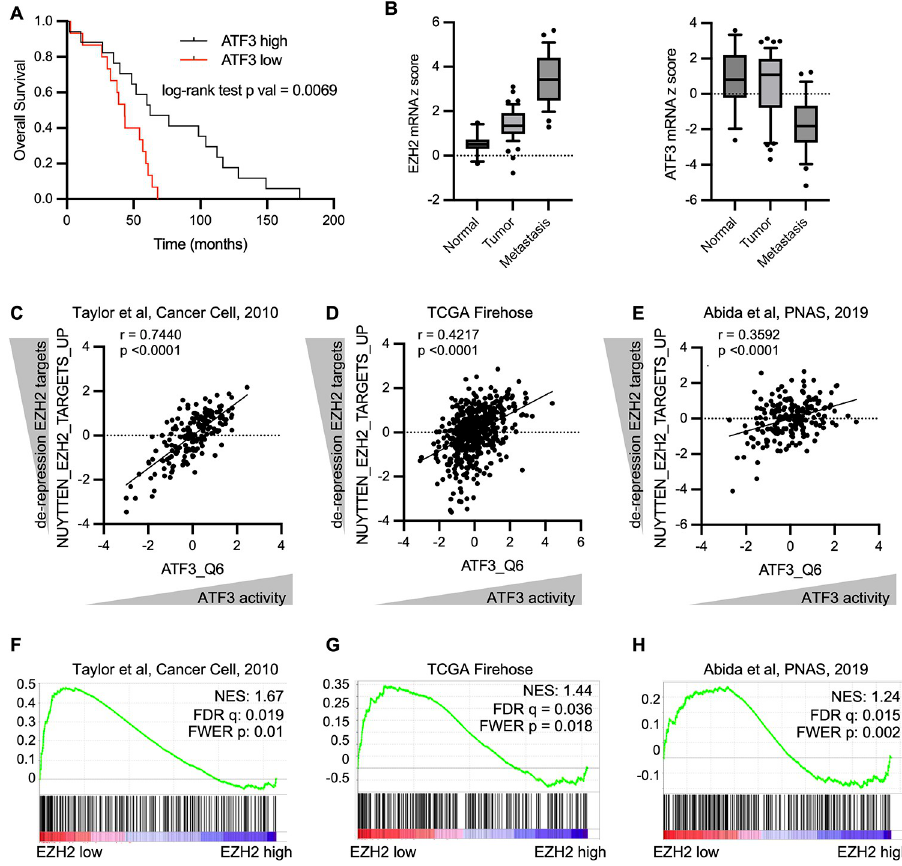
Fig 4. Low ATF3 expression is associated with decreased survival and EZH2 and ATF3 signatures inversely correlate in human prostate cancers. (A ) Kaplan–Meier survival curve depicting survival of patients with high ATF3 transcript expression (top 10% of all samples) vs. patients with low ATF3 transcript expression (bottom 10% of all samples) (S4 Data). ( B ) Box plot depicting expression of EZH2 mRNA (left) or ATF3 mRNA (right) in normal prostate, primary prostate adenocarcinoma, or metastatic prostate cancer (S4 Data). Box plot of EZH2 mRNA is same as in Fig 1A for comparison purposes. Data obtained from Grasso and colleagues [45]. ( C-E ) Correlation plots of ATF3 transcriptional sigantures (ssGSEA for ATF3_Q6) compared to EZH2 transcriptional signatures (ssGSEA for NUYTTEN_EZH2_TARGETS_UP) in 3 studies. An increase in the NUYTTEN signature indicates increased derepression of EZH2 targets. An enrichment of ATF3 signatures is depicted as increased ATF3 activity. R value is the Pearson correlation coefficient (S4 Data). ( F-H ) GSEA of ATF3 transcriptional program (gene set: ATF3_Q6) in EZH2 high and EZH2 low tumors in 3 datasets. EZH2, enhancer of zeste homologue 2; FDR, false discovery rate; FWER, family-wise error rate; GSEA, gene set enrichment analysis; NES, normalized enrichment score.